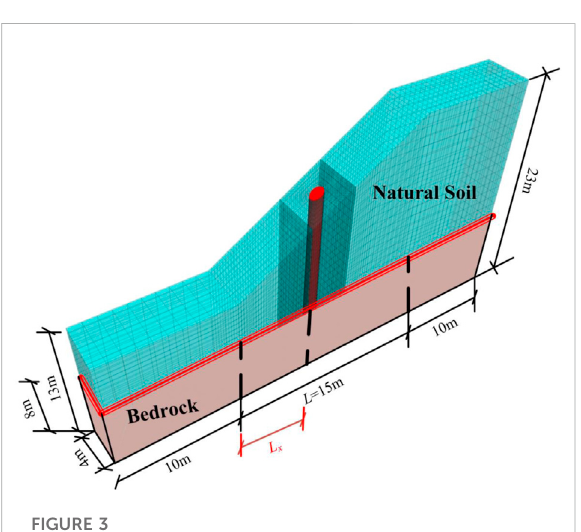
FIGURE 3 Schematic illustration of a homogeneous soil